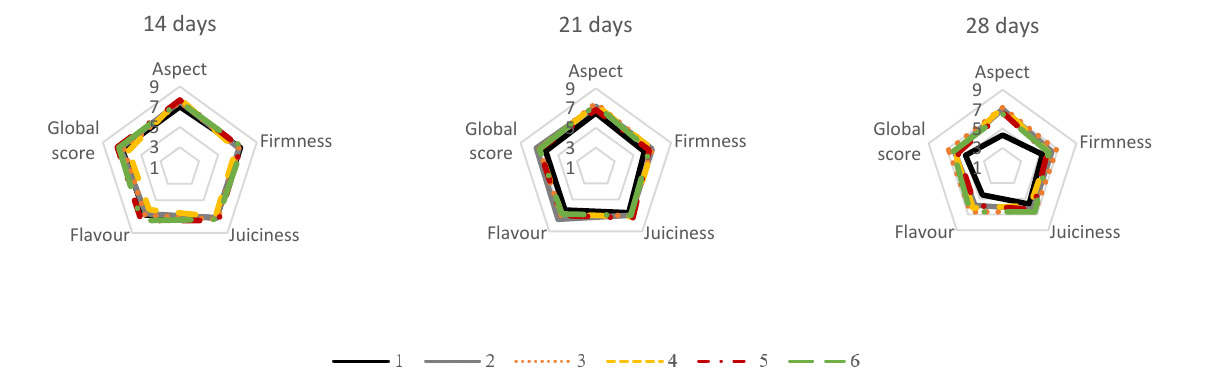
Figure 5. Results from the sensory evaluation of sweet cherries cv. Satin in 2020 after 14 days, 21 days and 28 days. The evaluation followed a 9-point scale ranging from 1 (dislike extremely) to 9 (like extremely). Treatment 1 was located at FO under normal atmosphere conditions. Treatments 2 to 6 were located at RC. Treatment 2 was under normal atmosphere conditions. The atmosphere compositions of treatments 3 to 6 were 3%O 2 –10%CO 2 , 3%O 2 –15%CO 2 , 10%O 2 –10%CO 2 and 10%O 2 – 15%CO 2 , respectively.